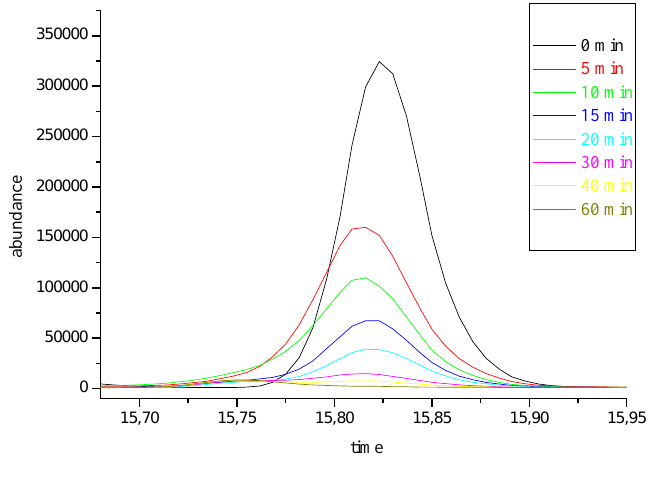
Figure 1. Irradiation of 1-iodocyclohexene in methanol ( λ monitored by